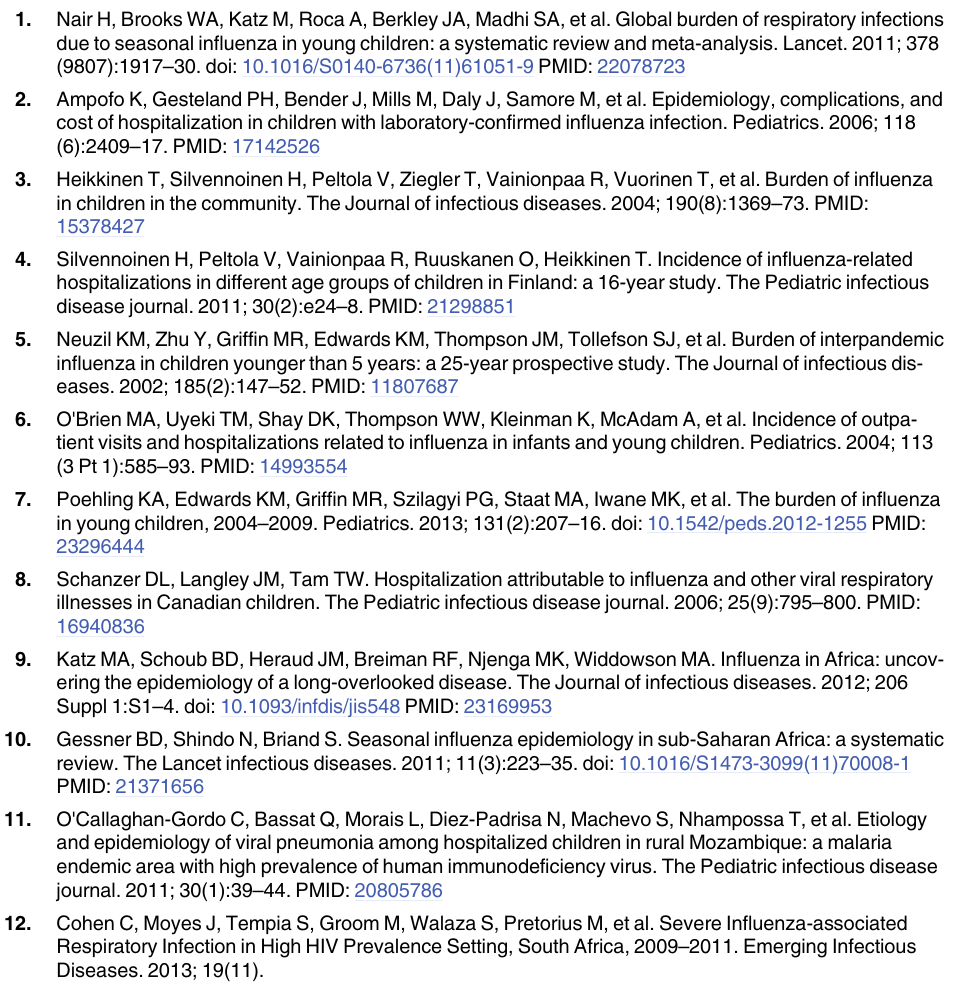
S1 Table. Person-time of Surveillance in weeks in Lwak and Kibera for Children 0 – 4 years of Age by Calendar Month, 2008 –